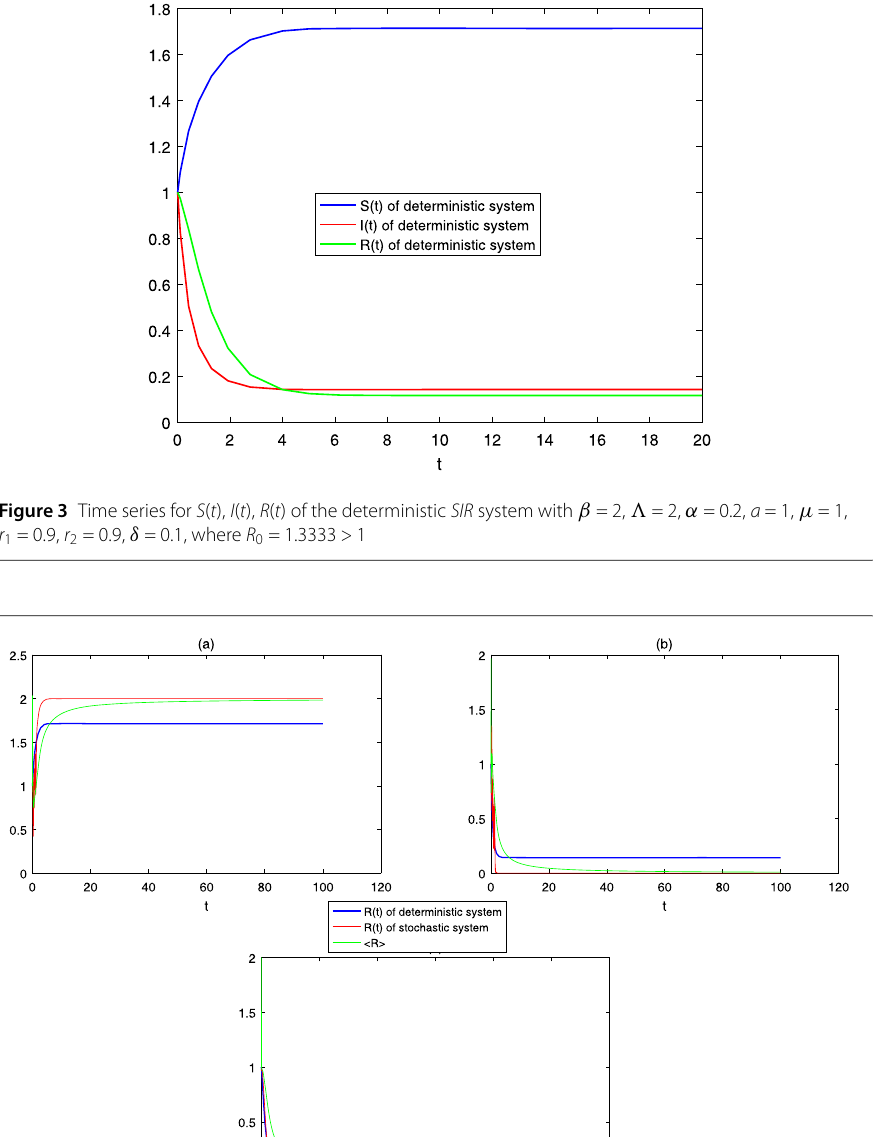
set parameters as (cid:2) = 2, α = 0.2, β = 1, a = 1, μ = 1, r 1 = 0.9, r 2 = 0.9, δ = 0.1 in system (1.1). A simple computation shows that R 0 = 0.6667 < 1, then system (1.1) has a stable disease-